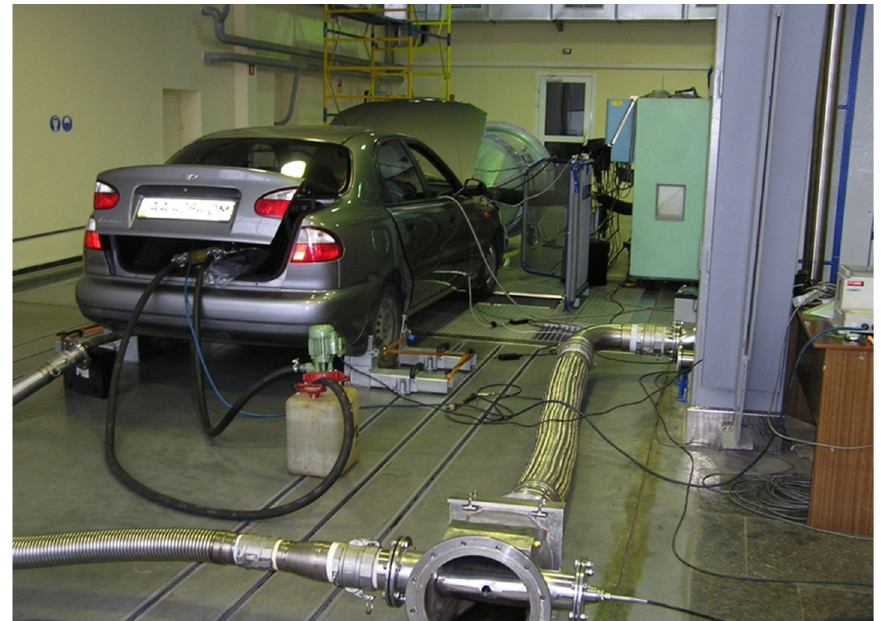
Figure 3. The 2007 Daewoo Lanos during bench